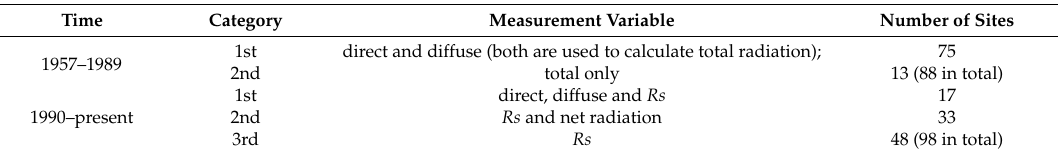
Table 1. Measurement method and calibration procedure for surface solar radiation ( Rs ) instruments in China [58,59]. Measurement Variable Number of